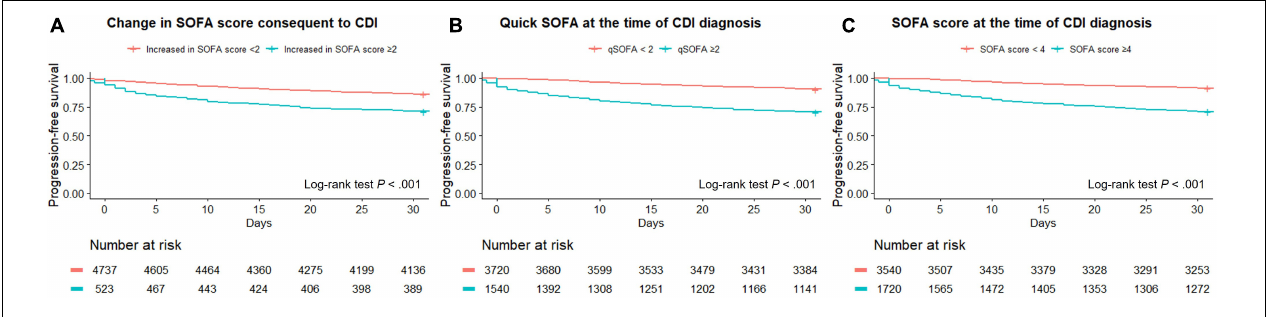
FIGURE 1 | Progression-free survival curves for three types of SOFA SCORES, including changes in SOFA score (A) , quick SOFA (B) , and SOFA (C) .